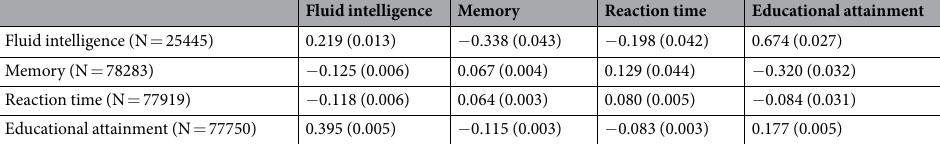
Table 2. The proportion of the phenotypic variance (diagonal) and genetic correlation (upper diagonal) explained by genome-wide SNPs and phenotypic correlation (lower